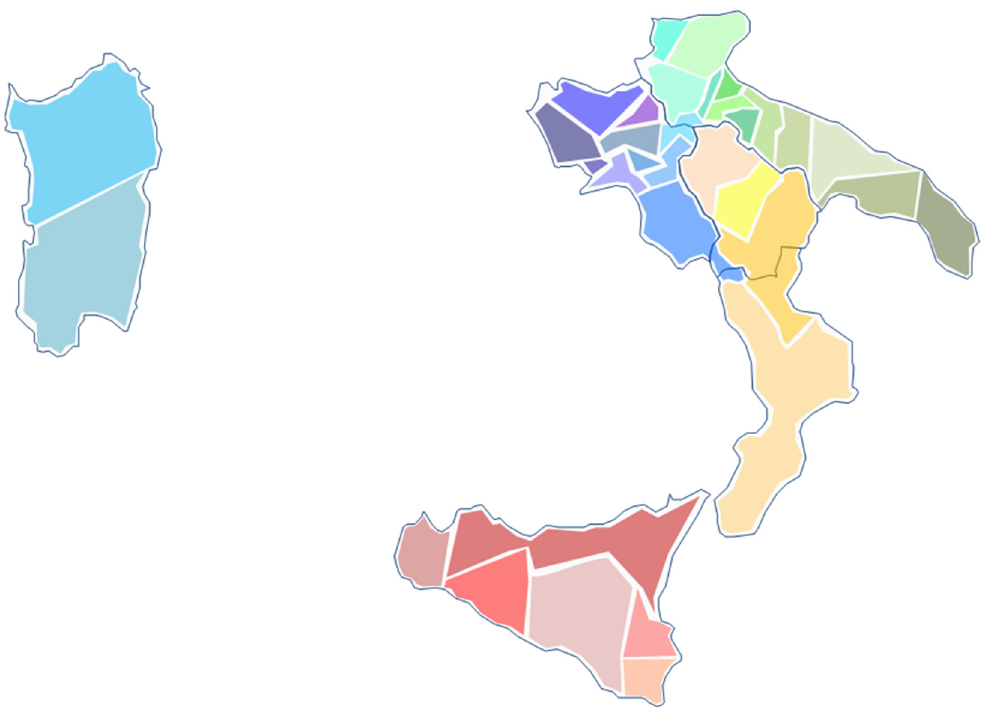
Figure 9. Operation islands defined for areas under consideration. The different colours represent the portions of territories served by the subtransmission power lines belonging to the same opera- tion island.